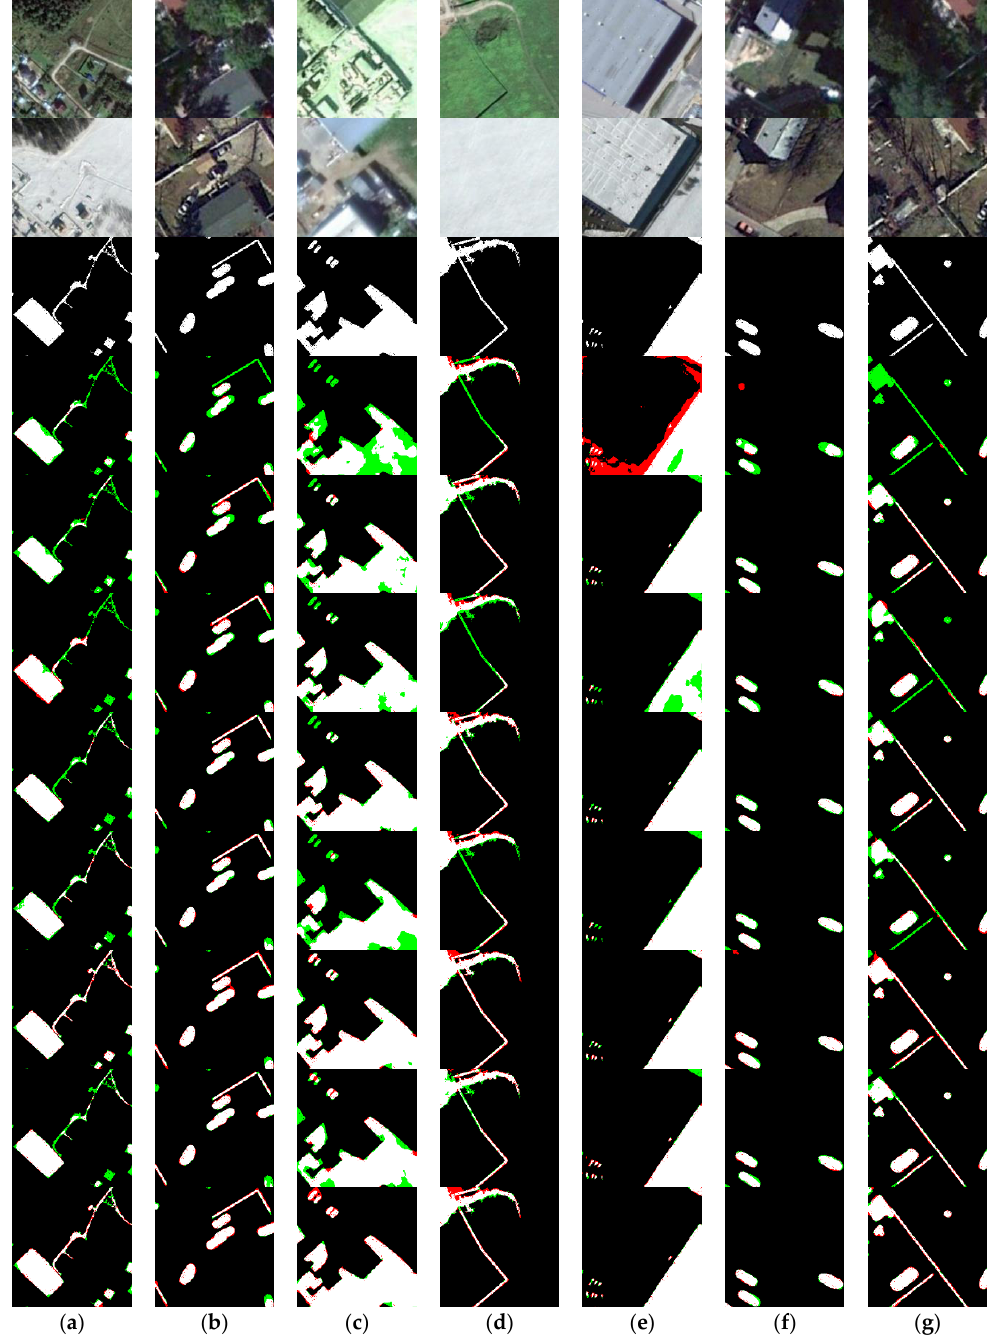
Figure 8. Visual ablation results of EAWLoss. ( a – g ) represent the results of different sample pairs. For each column, from top to bottom: baseline with CE, baseline with EAW, ASPCA with CE, ASPCA (with EAW), CCR with CE, CCR with EAW, both modules with CE, and both modules with EAW.